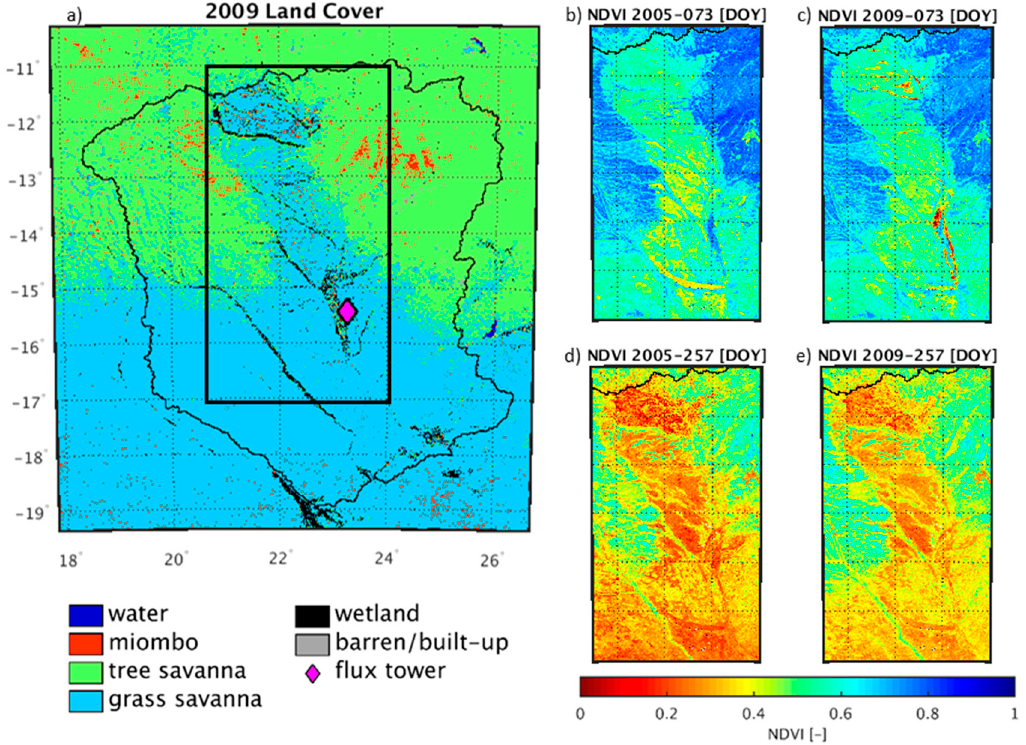
Figure 2. Maps of the UZRB study region. ( a ) Land cover for 2009 derived from MODIS MCD12Q1 and simplified to represent southern Africa. The black rectangle shows the outline of the inset panels on the right side of the figure. ( b – e ) The Normalized Difference Vegetation Index (NDVI) for a wet ( b , c ) and dry ( d , e ) period in 2005 and 2009 showing the variability in vegetation around the wetlands. NDVI was derived from the MODIS MCD43B4 data as described in Section 2.3.1. The ZM-Mon (Mongu, Zambia) CarboAfrica site location is displayed.